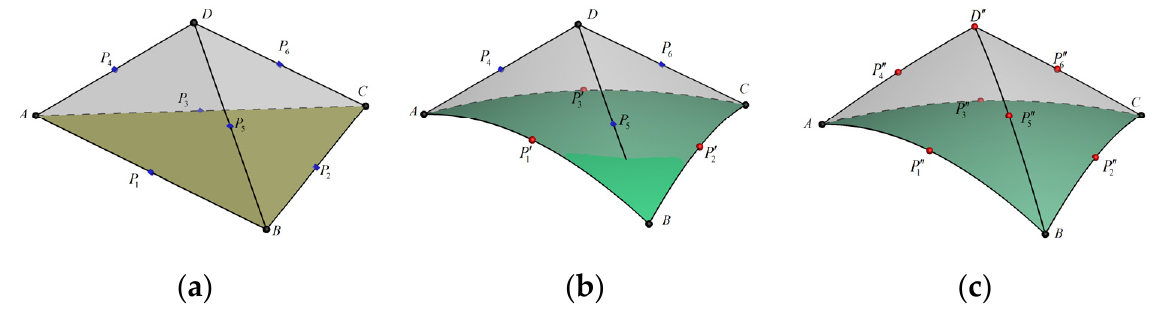
Figure 3. Schematic illustrations of RBF interpolation: ( a ) straight; ( b ) invalid (displacements of control points); and ( c ) valid (RBF interpolation).